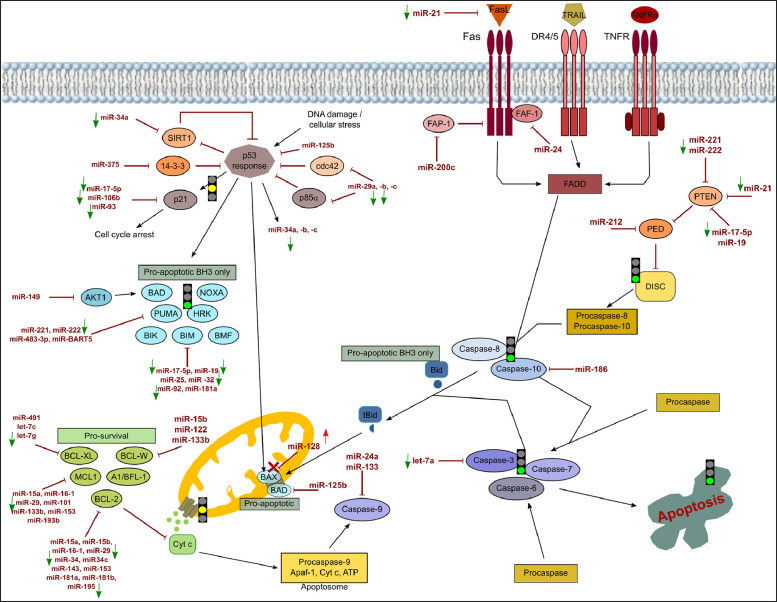
The core apoptotic pathway and its regulation by miRNAs in HepG2 cells exposed to 2.3 µg ml−1 Cd, as 5.2 µg ml−1 Cd(II). The figure depicts events in the intrinsic and extrinsic apoptotic pathways. In the whole pathway, point and block arrows indicate activation or inhibition, respectively. In the experimental conditions, the arrows next to the miRNAs indicate an increase or decrease of the miRNA. A red arrow indicates an increase in a specific miRNA and its target repressed is indicated with a red cross.. A green arrow indicates a decrease with lack of repression of its specific target. As a result, the specific step is unlocked (green light) or could be unlocked (yellow light).Note: DIANA-Tarbase database and DIANA-mirPath were used to obtain the data to create this chart.